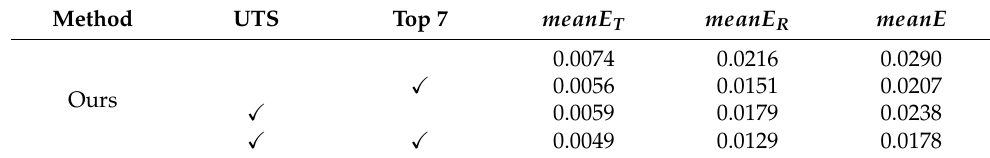
Table 3. Ablation study to evaluate the effectiveness of our UTS and Top 7